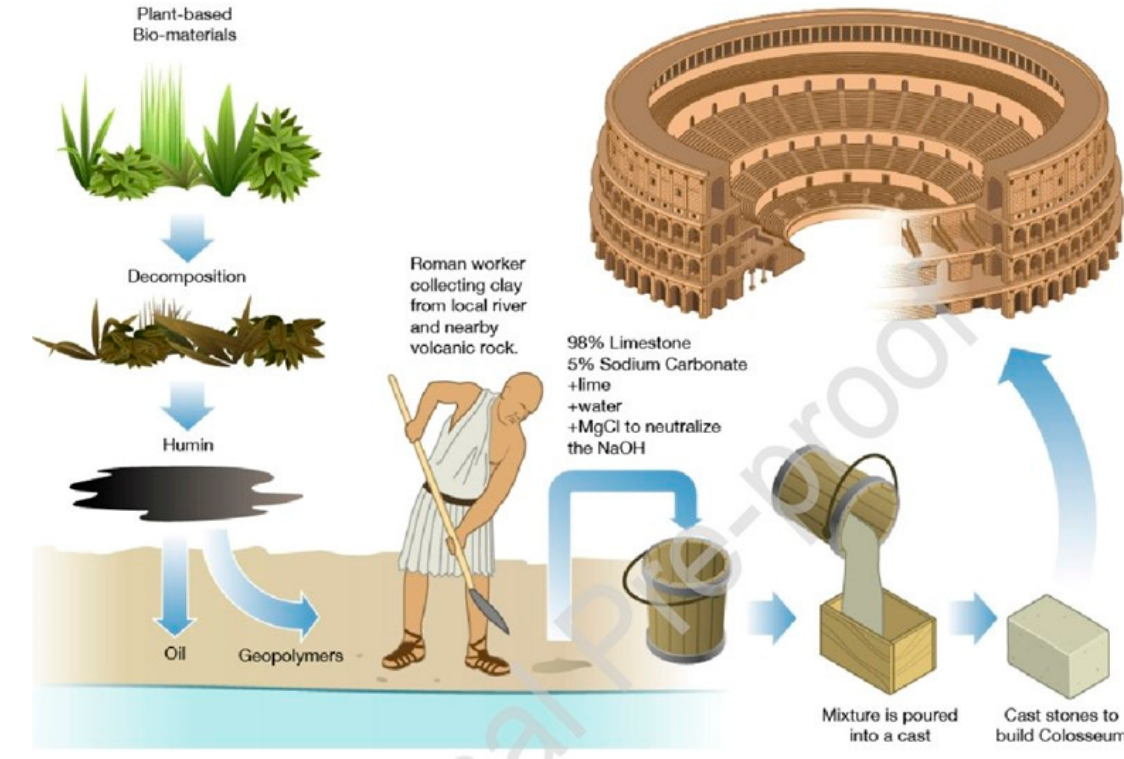
Figure 2. Manufacturing Process of GPCs in the Roman Kingdom [16].